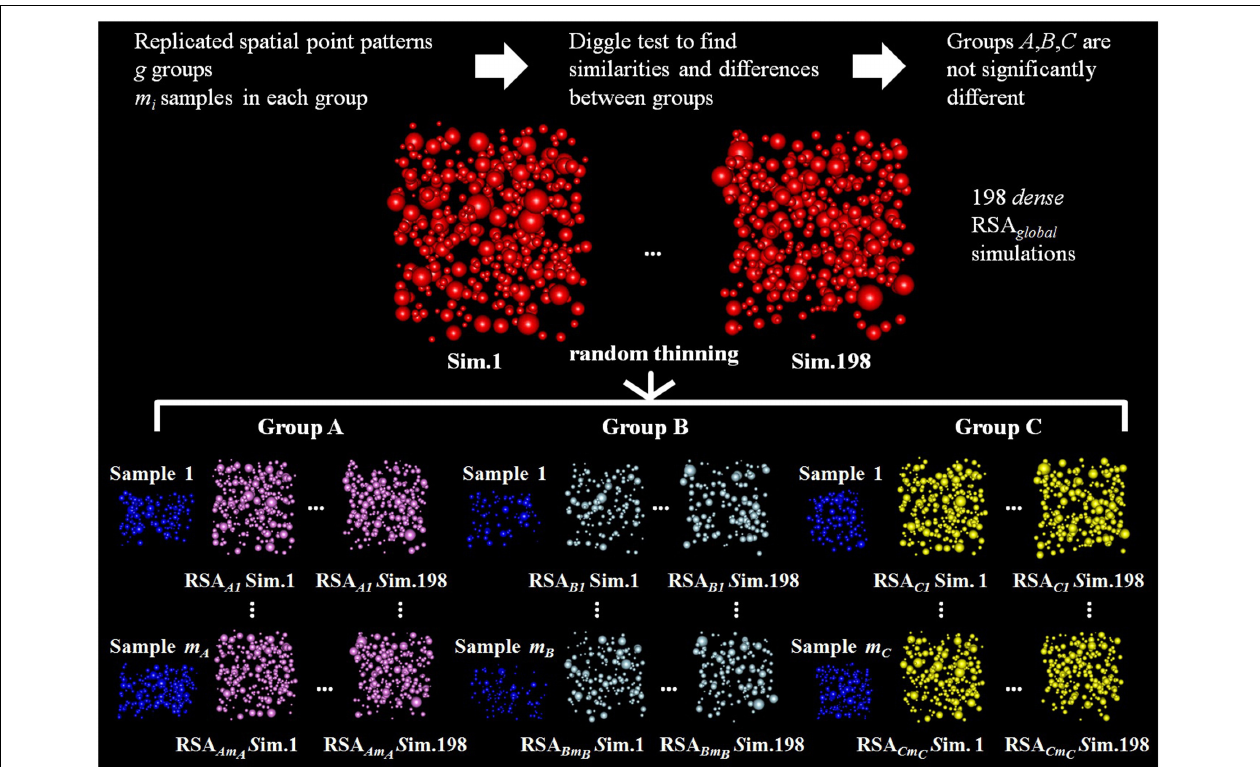
FIGURE 4 | Diagram of the random thinning process for three groups of replicated point patterns, A, B, and C, for which the Diggle test did not find significant differences. Our goal is to check if these groups are differentially thinned versions of a common underlying RSA process. Random thinning of dense simulations is performed for each experimentally observed sample j in each group i (test sample, shown in blue). Random thinning